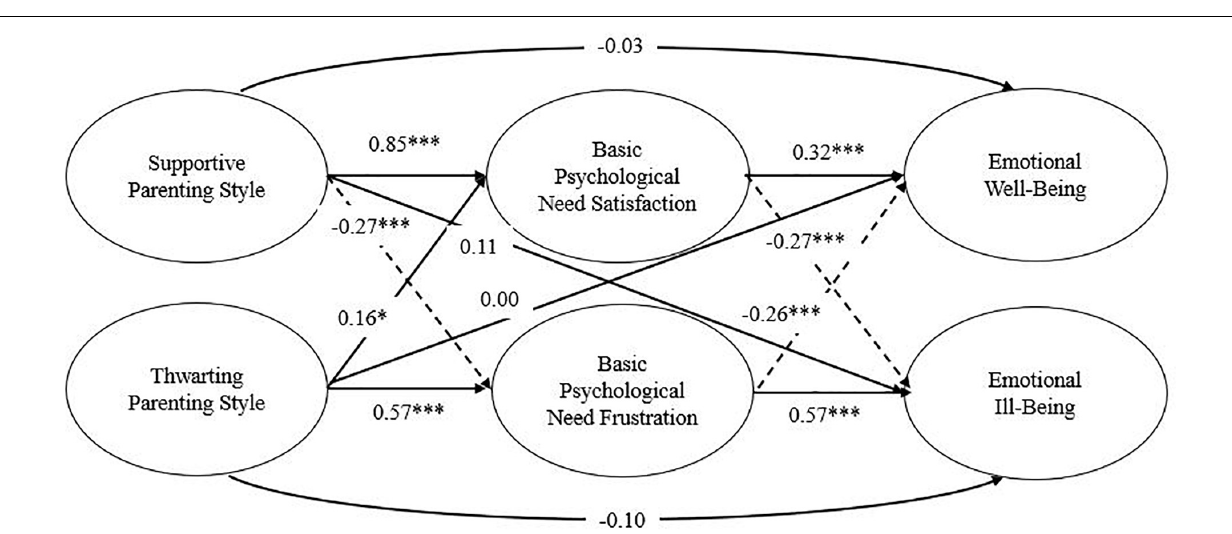
FIGURE 4 | Standardized structural equation of Model 3. Solid lines indicated positive relations, and dashed lines indicated negative relations. * p < 0.05, ** p < 0.01, *** p <